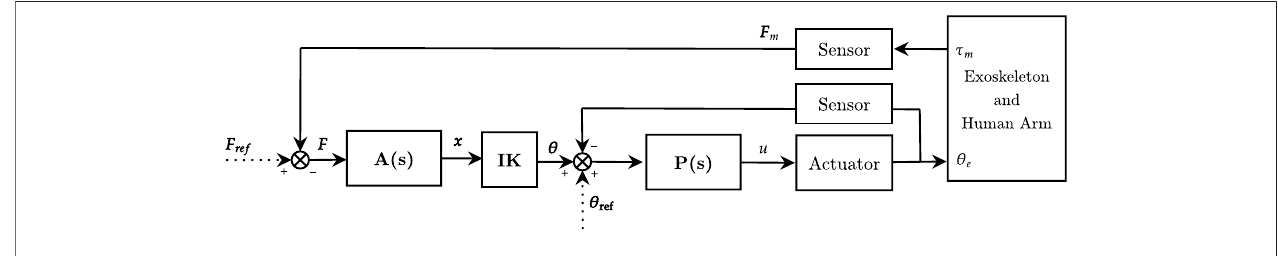
FIGURE7| Admittancecontrolschemeinthetask-space. A ( s )isthetask-spaceadmittancecontroller, P ( s )isthejoint-spacepositioncontroller. IK correspondsto the inverse-kinematics algorithm. θ ref and τ ref represent respectively reference angular position and torque, while u refers to the motor current control signal.